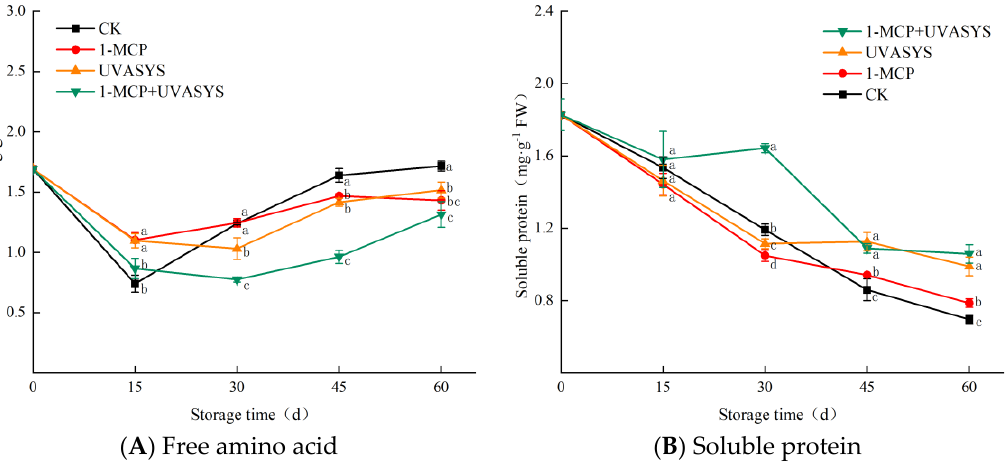
Figure 2. Effect of 1-MCP and UVASYS treatment on free amino acid ( A ) and soluble protein ( B ) content of bamboo shoots during storage. Each data point represents an average ± standard error ( n = 3). Different letters indicate significant differences among treatments for each sampling time at p < 0.05.